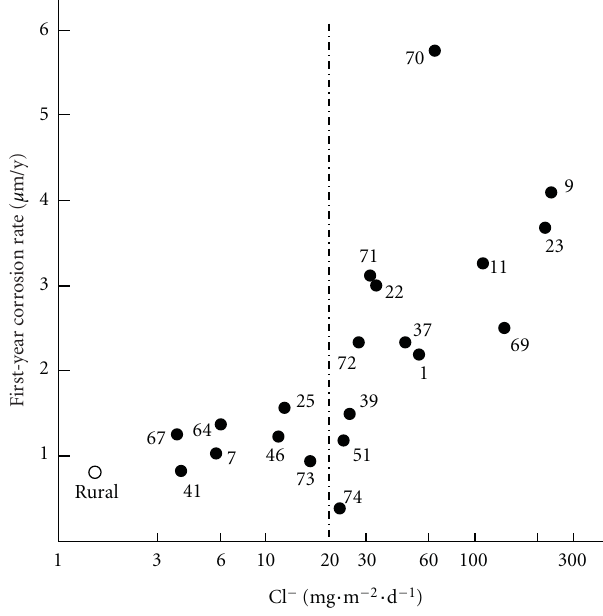
Figure 9: First-year copper corrosion rate versus Cl − deposition rate in marine (S 1 P 0 , S 2 P 0 , and S 3 P 0 ) atmospheres. In the graph, the average value of corrosion rate in rural atmospheres (O) is